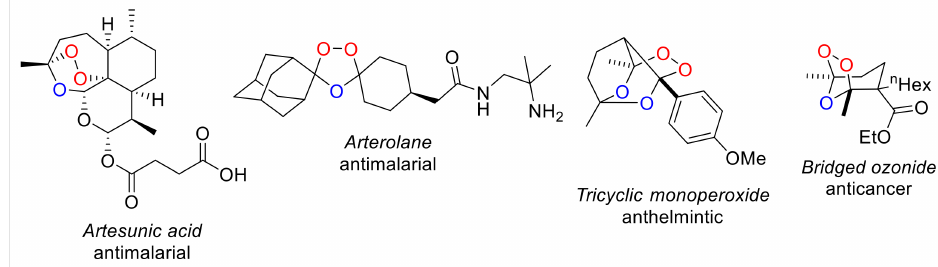
Figure 1. Bioactive